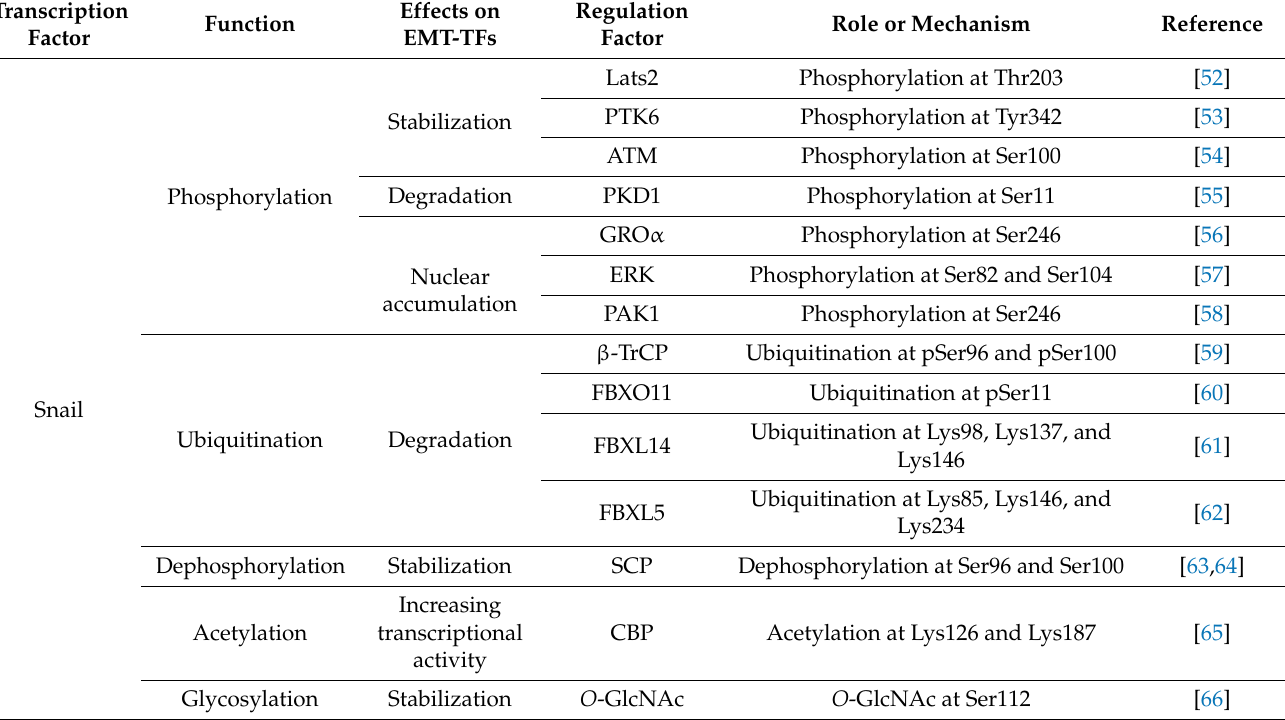
Table 1. Regulation of the Snail family by post-translational modifications